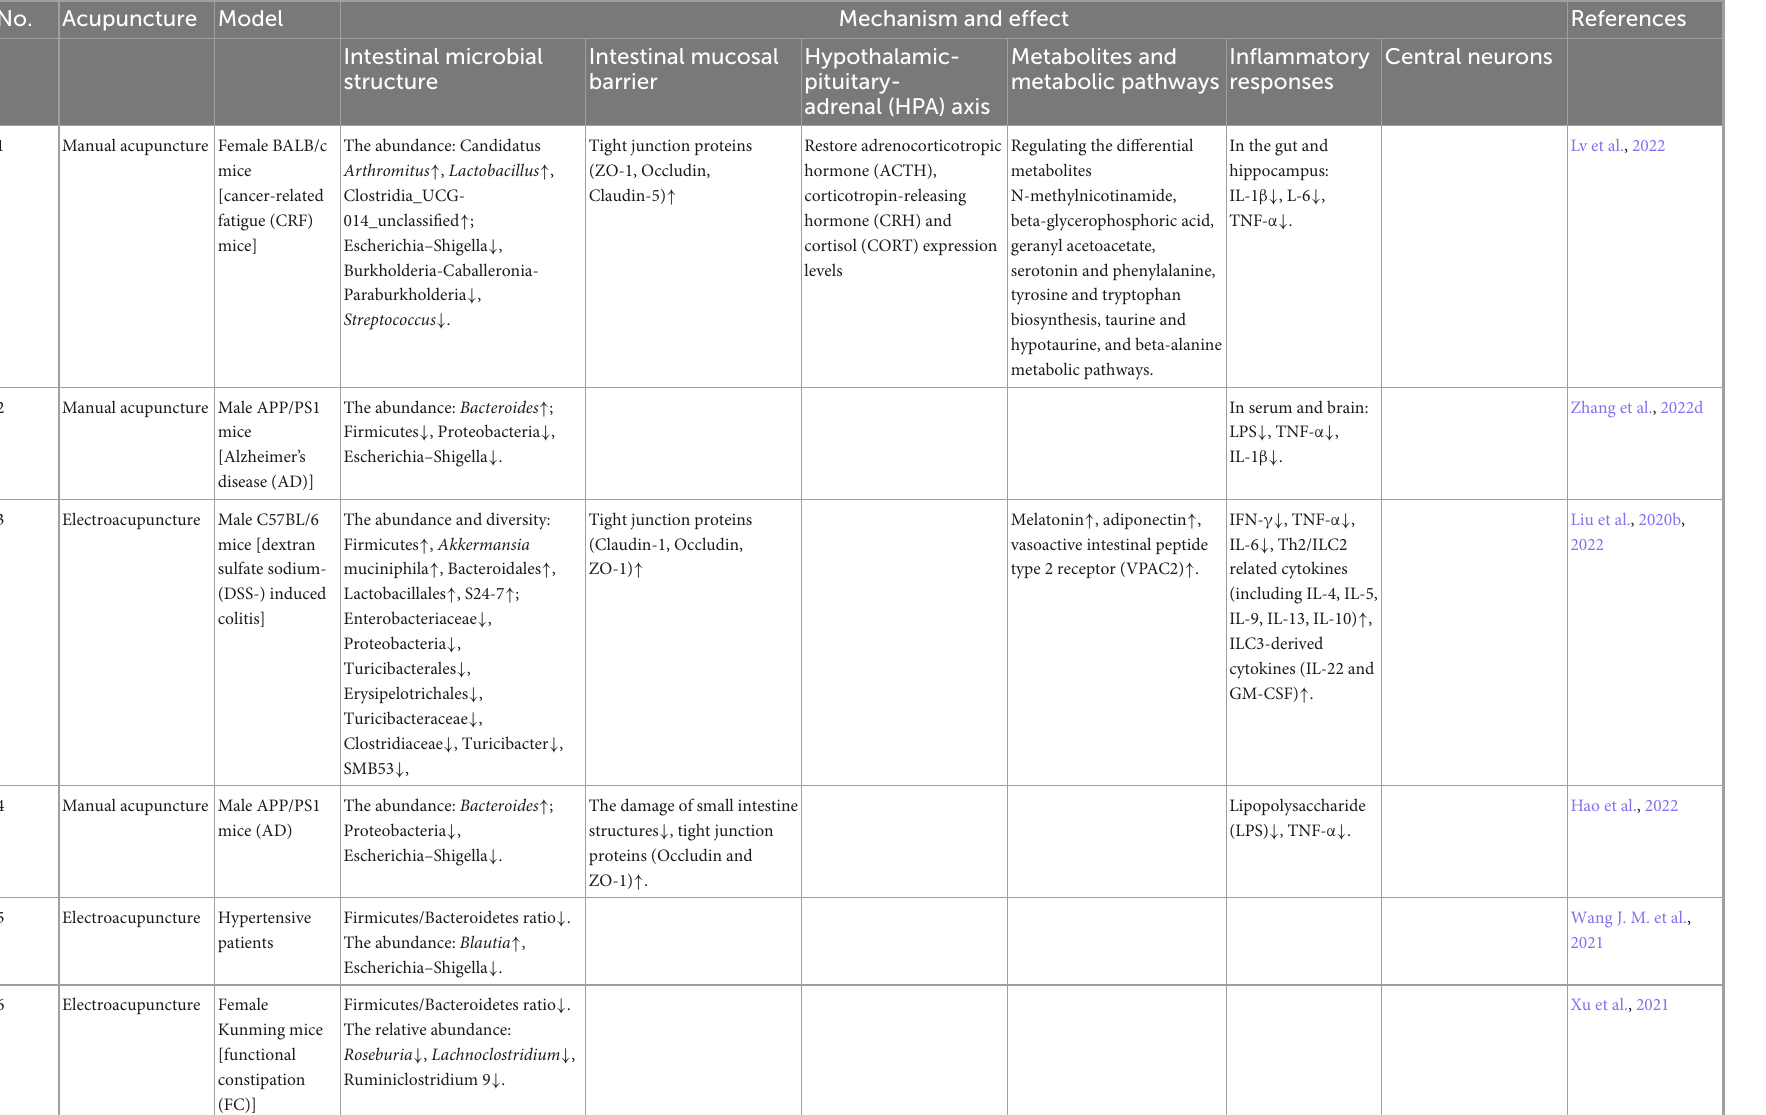
TABLE 1 The original researches on the regulation of intestinal microbiota by acupuncture.